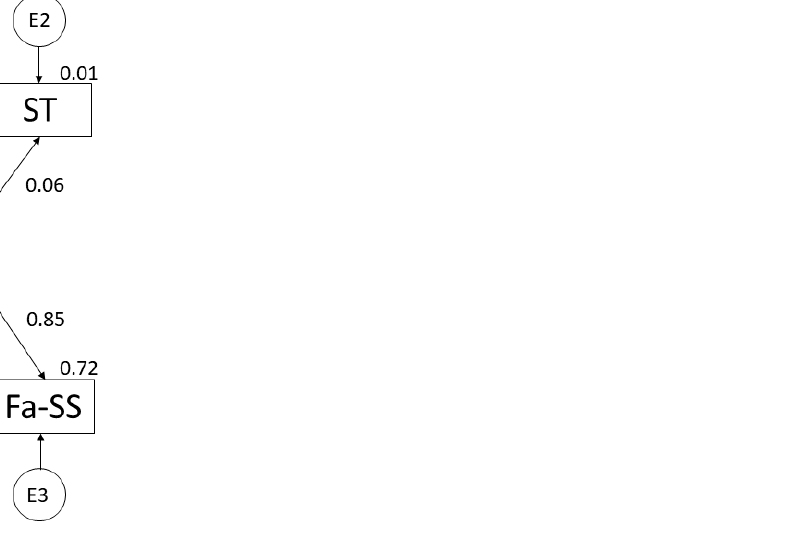
Figure 3. Theoretical model developed for males. Note: Physical Activity (PA); Social Support (SS); Screen Time (ST); Family Support (Fa-SS); Friends’ Support (Fr-SS). Table 3. Structure of the theoretical model for males. Variable Associations